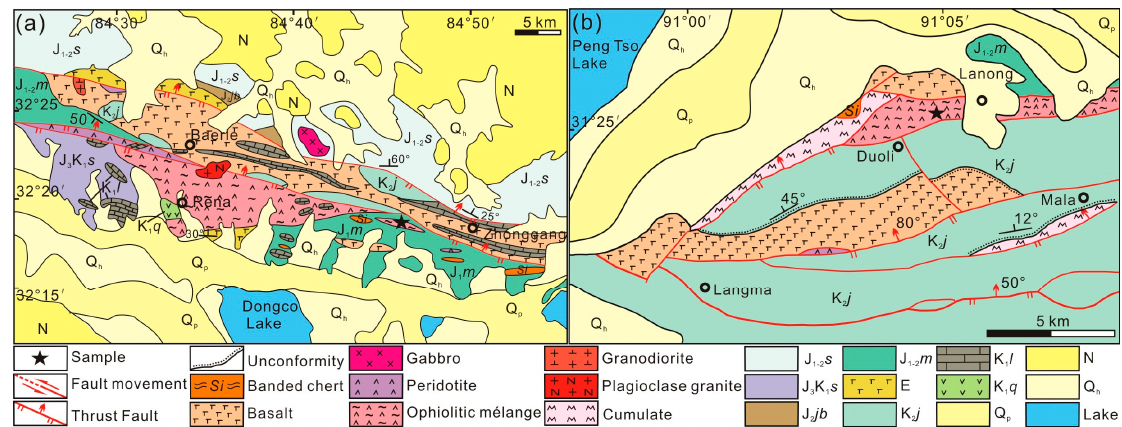
Figure 2. Geological maps of the Dongco ( a ; modified after [27]) and Lanong ophiolites ( b ; modified after [28]). The black asterisks indicate the sample locations. Note: K 2 j —Jingzhushan Formation, after [28]). The black asterisks indicate the sample locations. Note: K